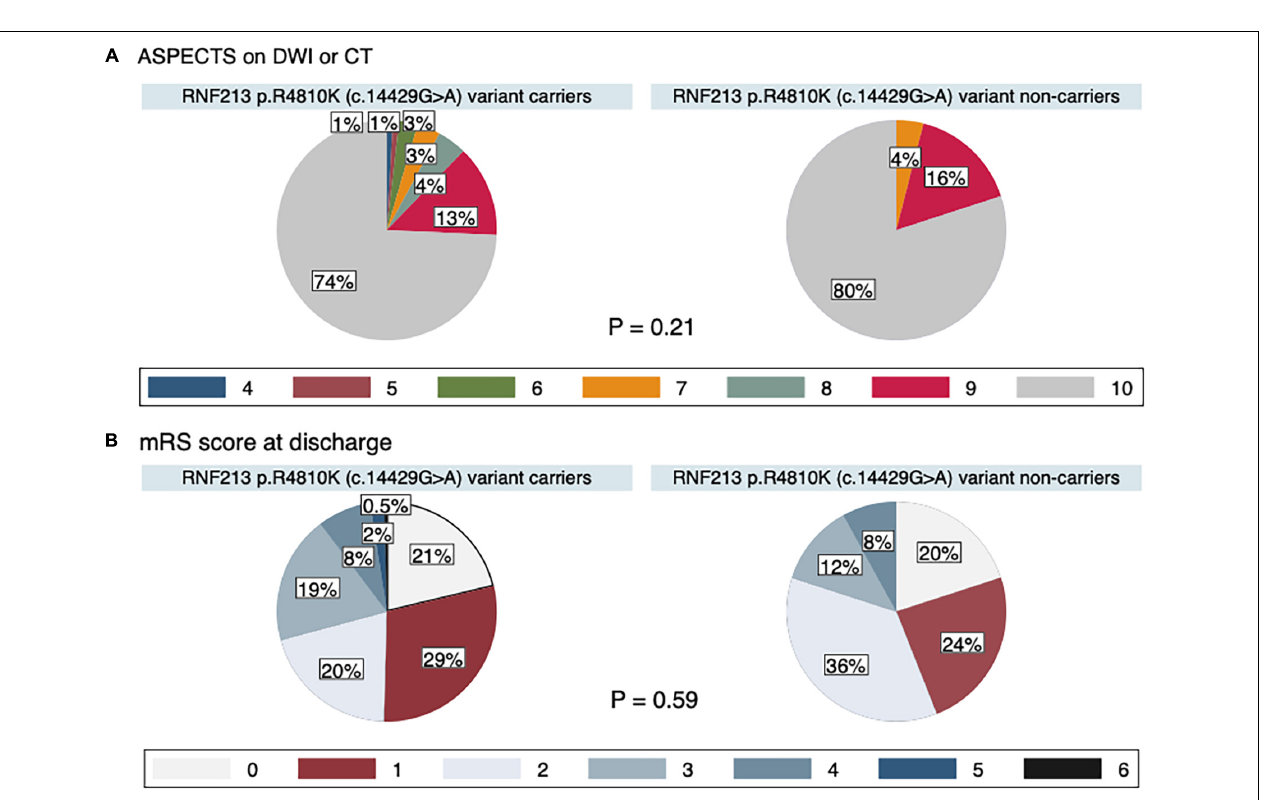
Frontiers in Aging Neuroscience |